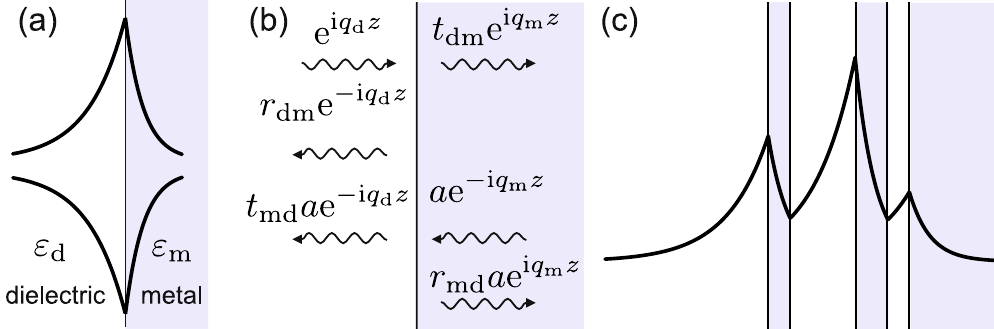
Figure 1. Schematics showing the general properties of stratified two-phase metallodielectric systems with an odd number of interfaces. ( a ) Two possible magnetic field variations which fulfill the interface boundary conditions. ( b ) Definition of Fresnel reflection and transmission coefficients. ( c ) Magnetic field of a mode fulfilling both the interface and boundary conditions at